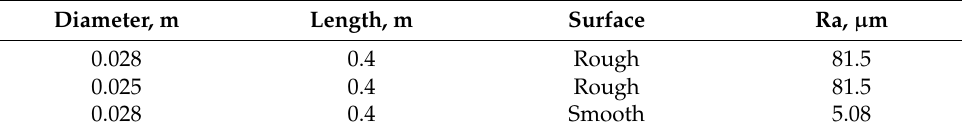
Table 1. Properties of piles.